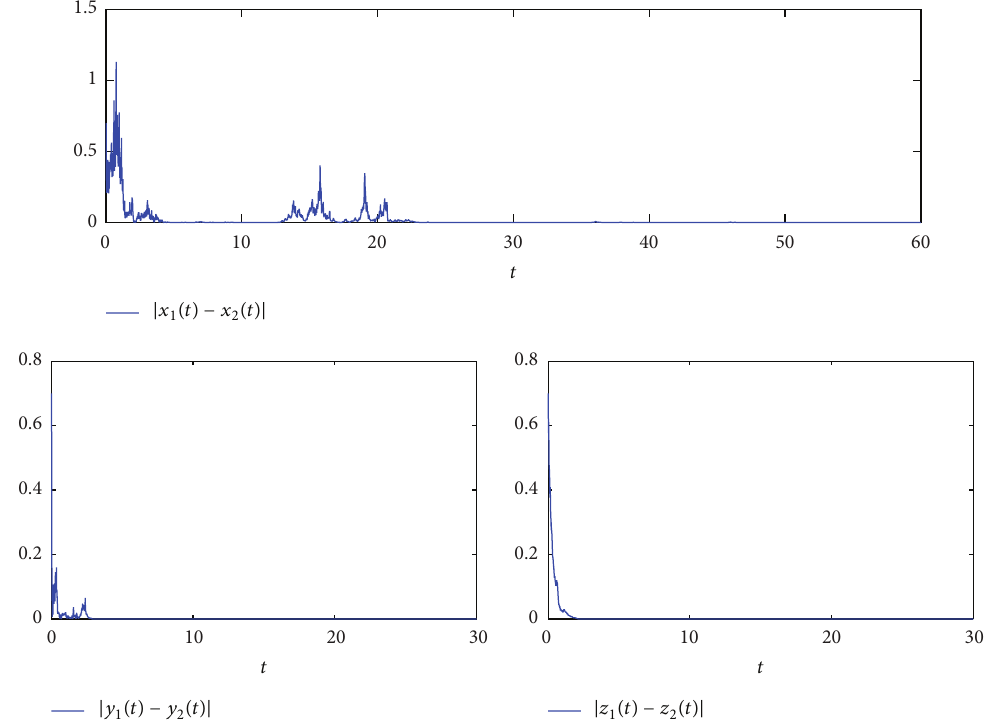
Figure 2: The curves of |𝑥 1 (𝑡) − 𝑥 2 (𝑡)| , |𝑦 1 (𝑡) − 𝑦 2 (𝑡)| and |𝑧 1 (𝑡) − 𝑧 2 (𝑡)| for initial values (𝑥 1 (0),𝑦 1 (0),𝑧 1 (0)) = (0.8,0.8, 0.8) and (0), 𝑦 (0), 𝑧 (0)) = (0.1, 0.1, 0.1) , Δ𝑡 = 0.01 (𝑥 2 2 2